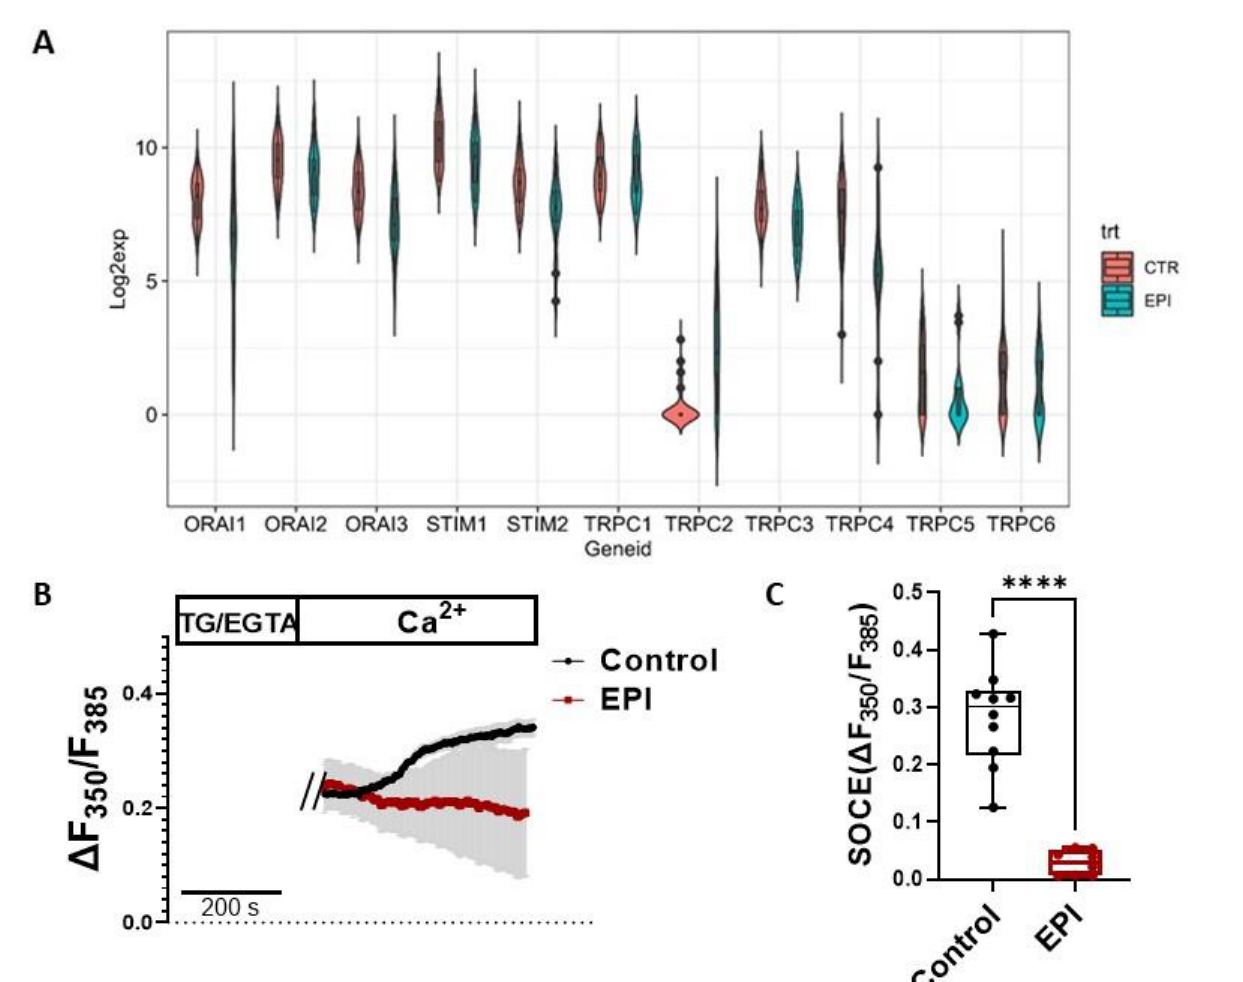
Figure 1. SOCE machinery genes were downregulated by EPI in cardiomyocytes. ( A ) RNA-seq data analysis of human iPSC-derived cardiomyocytes treated with 2 µ M EPI for 48 h. SOCE machinery genes include Orais, TRPCs, and Stims. ( B ) Representative traces of intracellular Ca 2+ in HL-1 cells treated with vehicle control or 1 µ M EPI for 6 h. ( C ) Statistics of changes in intracellular Ca 2+ in HL-1 cells without (0.28 ± 0.085) or with the treatment of EPI (0.02897 ± 0.021). Mean ± SD, n = 10, ****: p < 0.0001 (based on t -test).